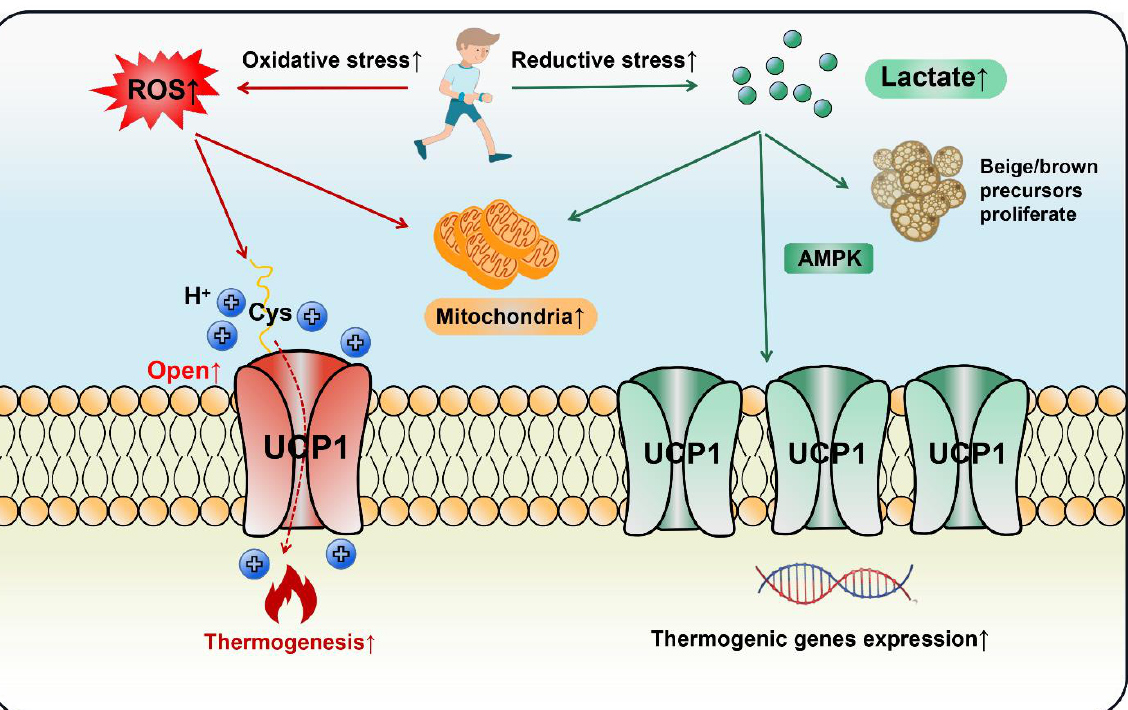
Figure 5. Both oxidative and reductive stress stimulate adipocytes’ thermogenesis and browning during exercise. In an oxidative stress state, ROS opens the UCP1 proton channel on the mitochondrial inner membrane to initiate thermogenesis by the thiol oxidation of UCP1 at cystine (Cys253). In a state of reductive stress, lactate as a reducing agent produced by exercise stimulates browning by up-regulating UCP1 expression through the AMPK pathway or directly promoting the proliferation of beige/brown precursor cells. In the exercise cycling of energy supply and expenditure (including one bout of exercise and chronic regular exercise), ROS initiates adipose thermogenesis immediately to compensate the daily energy expenditure, whereas lactate increases adipocytes mitochondrial biogenesis and browning through the adaptive up-regulation of UCP1.